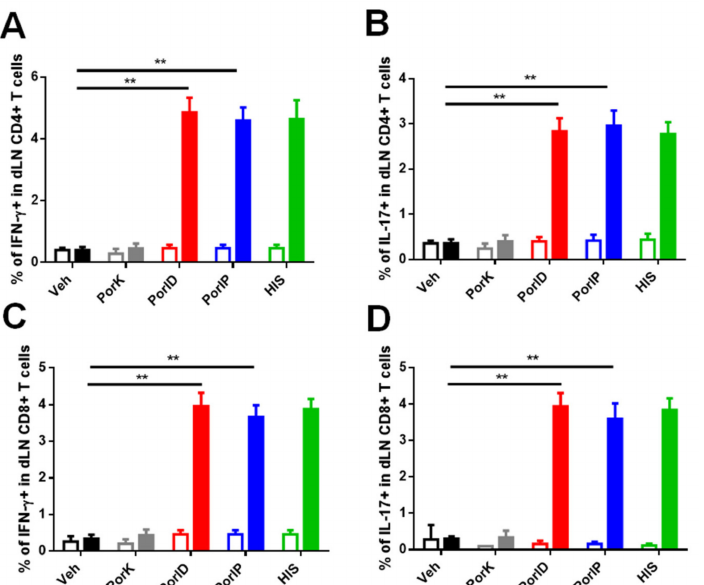
Figure A3. Percentage of functional CD4+ and CD8+ T cells in skin dLN. C57BL/6J mice were injected intradermally in the ear with vehicle (Veh), proteinase K-digested porins (PorK), porins (PorID), or intraperitoneally with porins (PorIP) or heat-inactivated S . Typhi (HIS) at day 0. All groups were boosted at day 14 with porins injected intradermally in the ear. Count of the percentage of IFN- γ - ( A ) and IL-17- ( B ) producing CD4+ T cells found in skin dLN at day 28. Same populations percentages were analyzed for skin dLN CD8+ T cells ( C , D ) ( n = 7; 2 independent experiments; significant difference for a Kruskal–Wallis test ** p < 0.05 * p < 0.1 with Dunn’s multiple comparison).